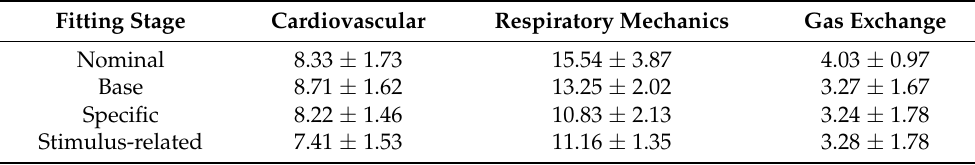
Table 6. Prediction error results (%) at each fitting stage for the model